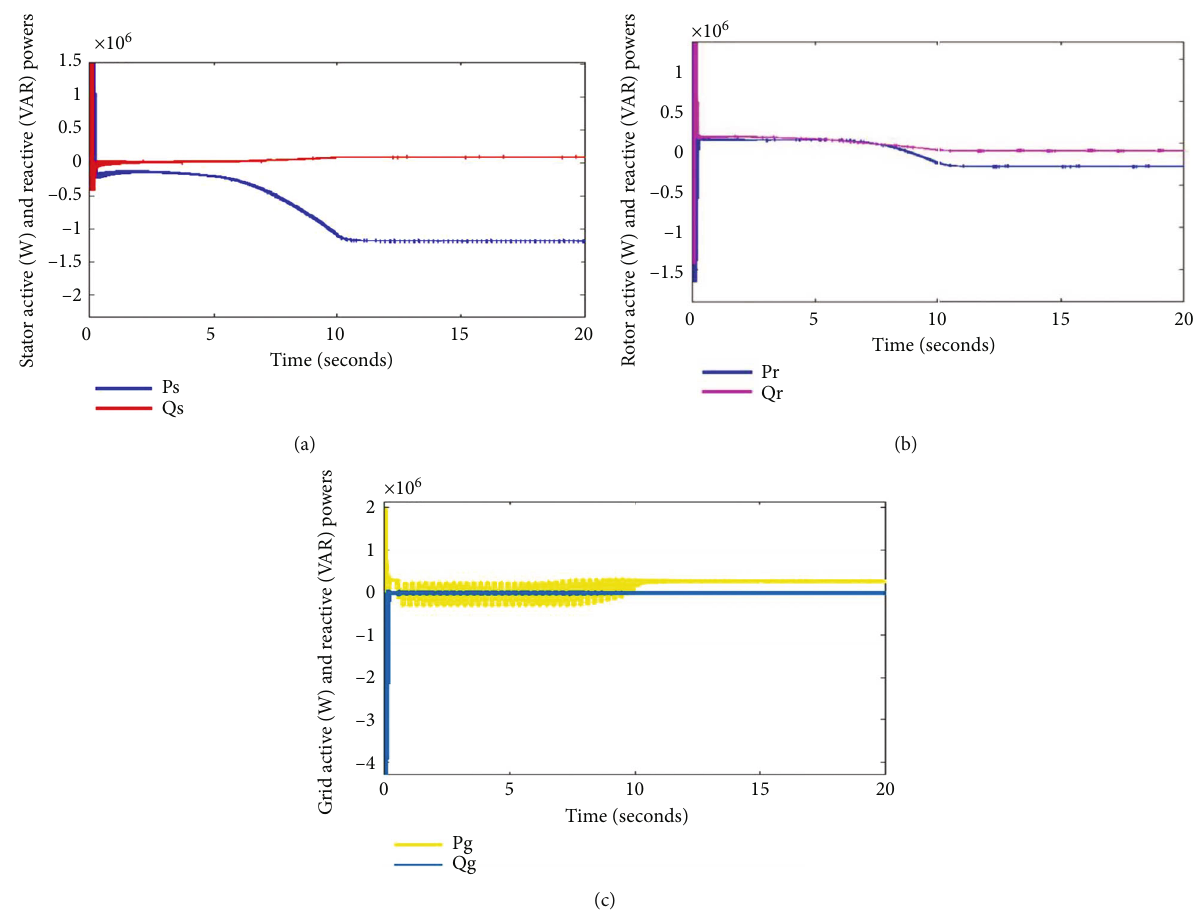
Figure 15: (a – c) Stator, rotor, and grid active and reactive powers using PI-tuned